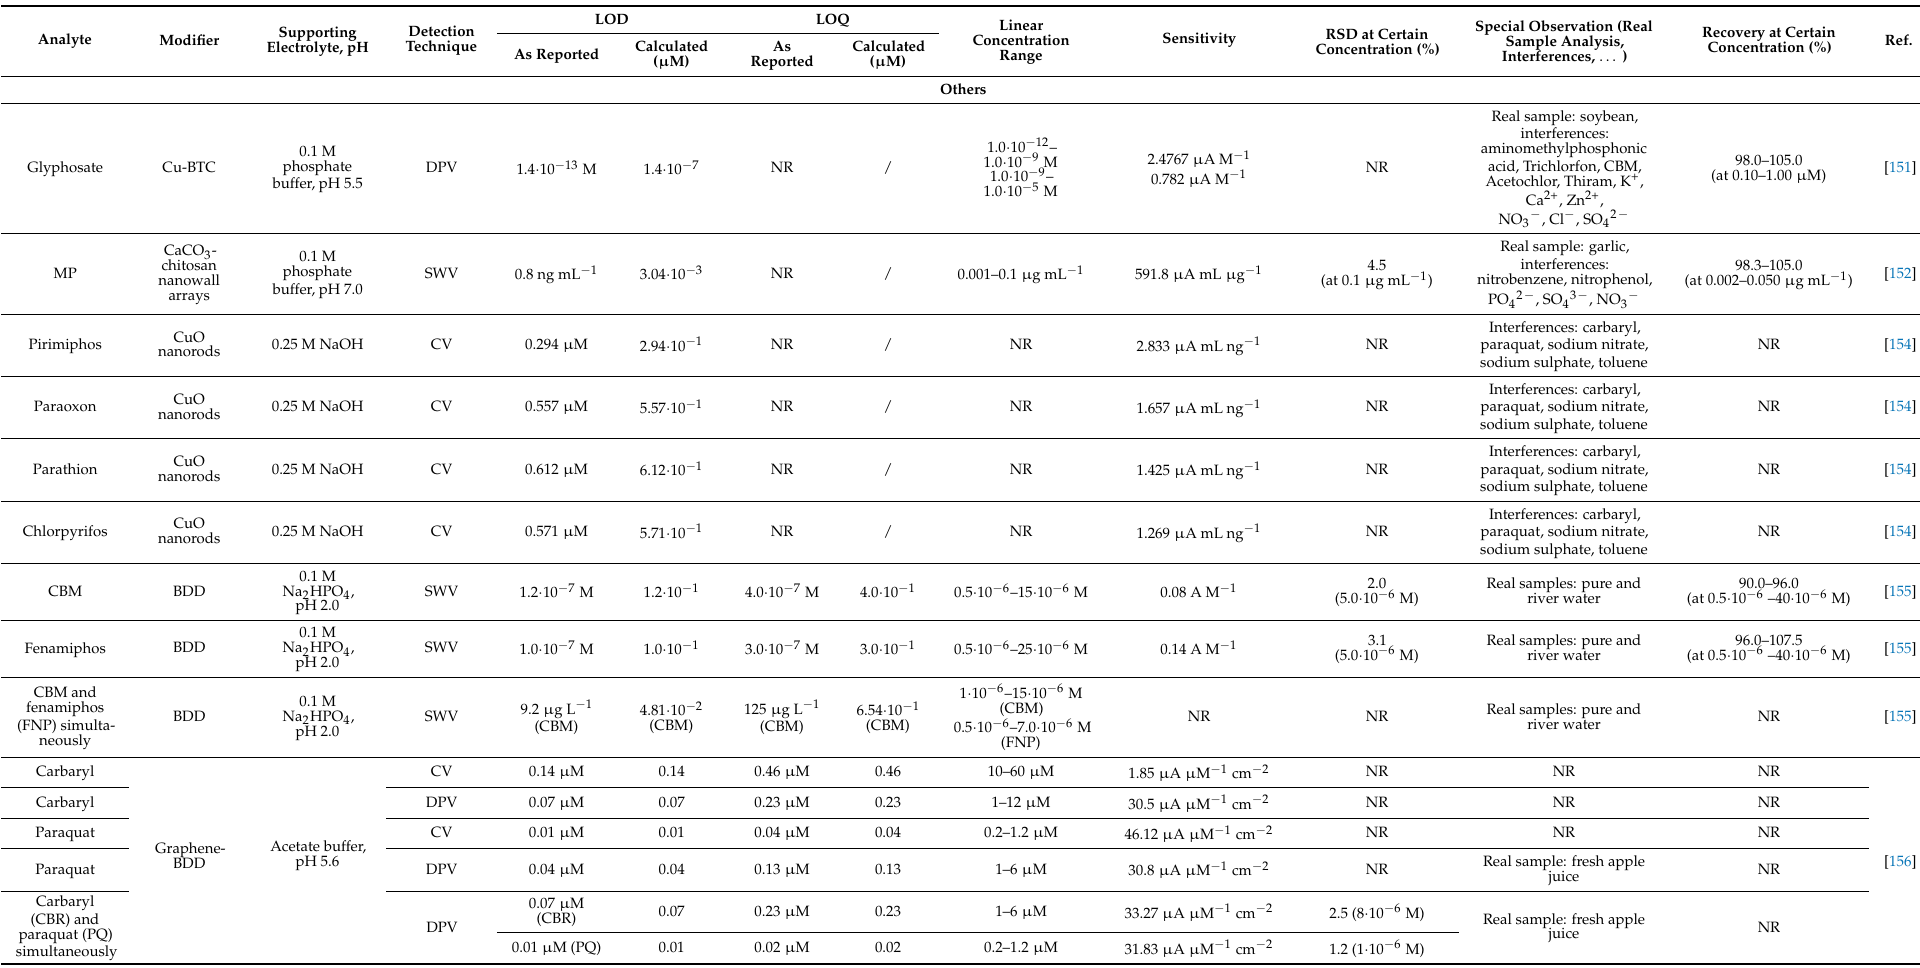
Carbaryl (CBR)and paraquat(PQ)